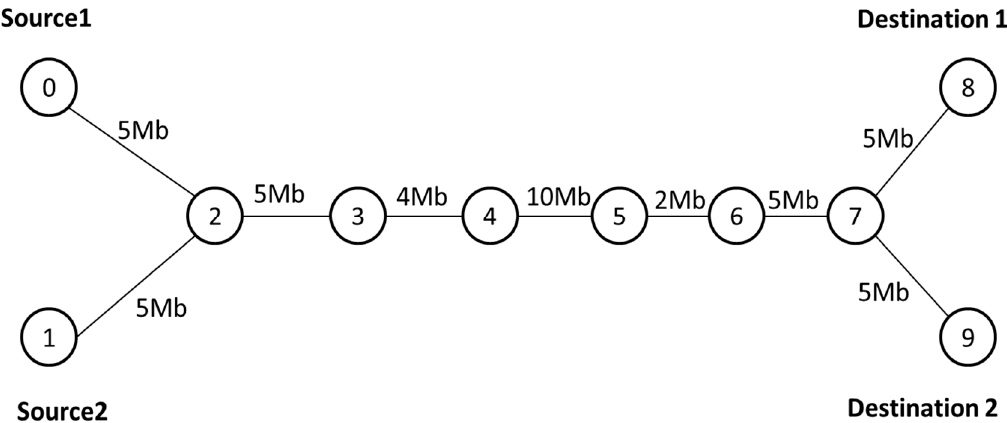
Figure 2. Dumbbell Figure 2. Dumbbell topology.